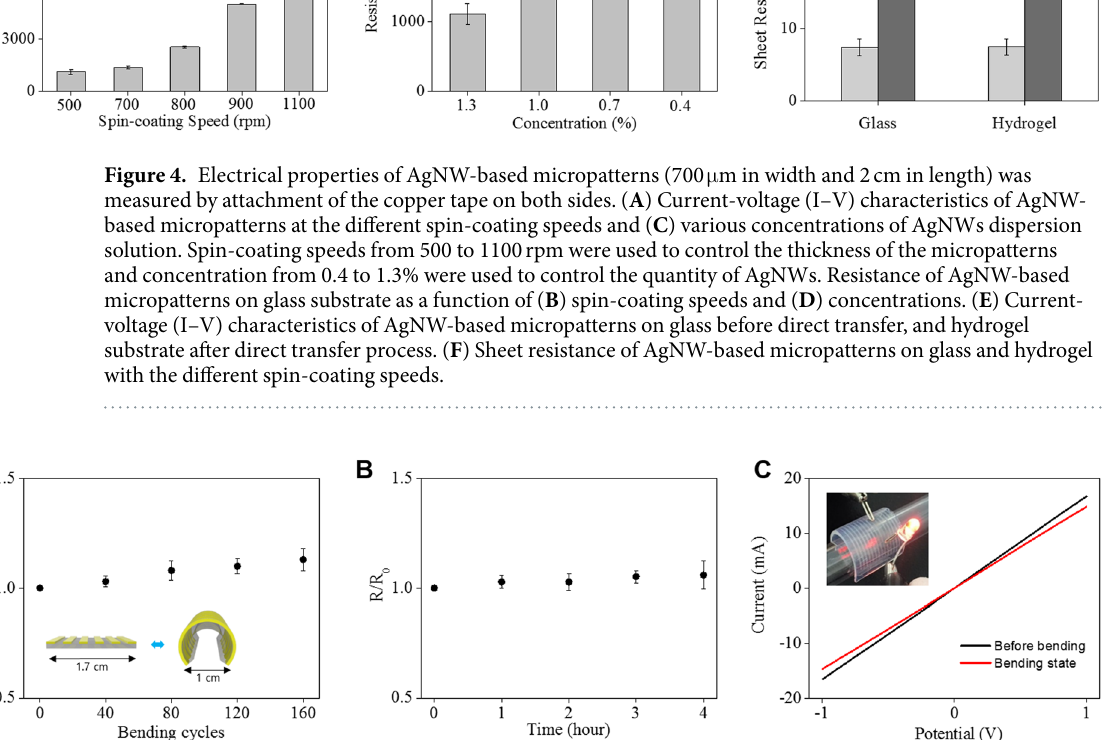
(Fig. 7). The relative change of the resistance (RCR) value ((R − R 0 )/R 0 ) was calculated by resistance value obtained from the I–V graph at different pressures. It can be seen that the RCR value gradually decreased with pressure increasing from 0 to 10 kPa. It is important to note that AgNW patterns on hydrogel were highly respon- sive to low pressure sensing range ( < 2.5 kPa). It has been known that ideal blood pressure for a healthy adult is 16 kPa (120 mmHg) systolic and 11 kPa (80 mmHg) diastolic. Overall, the novel strategy described herein can enhance our ability to develop highly conductive, hydrogel-based microelectrodes for next-generation bioelec- tronics systems such as implantable blood pressure sensor.